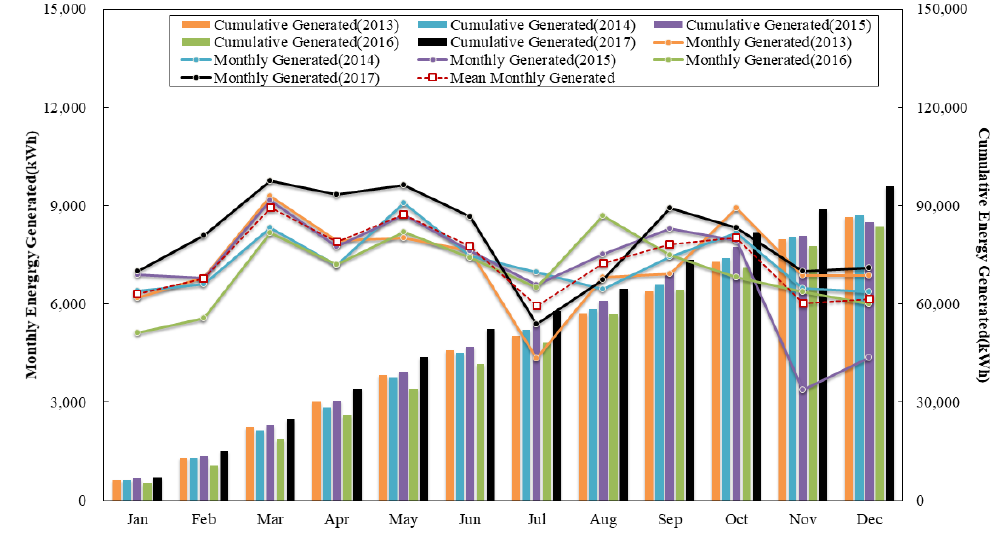
Figure 5. Monthly and accumulated energy production.